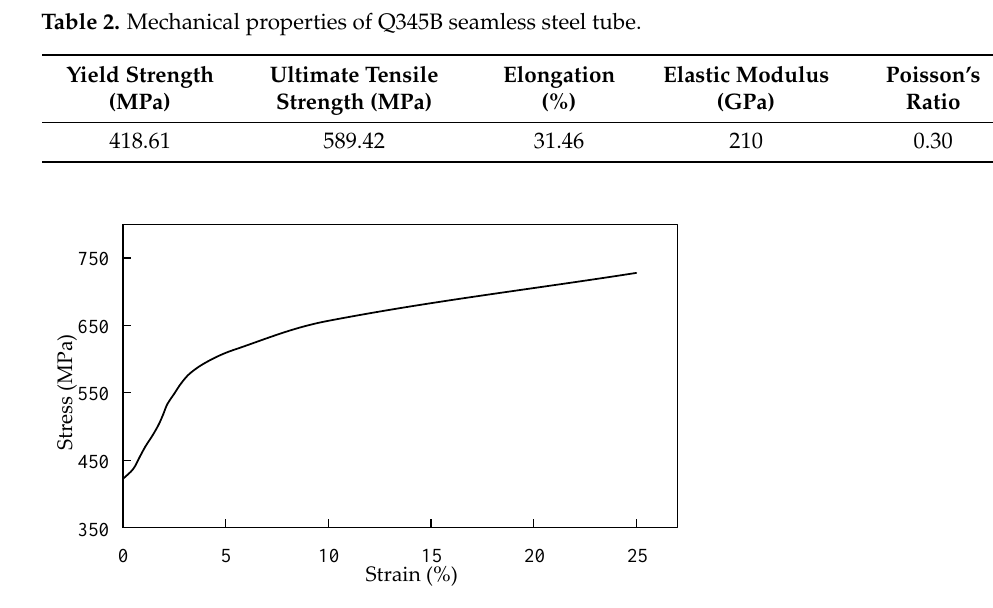
Figure 2. Stress-strain curve of the initial tube. On the tube’s outer surface, the circles are drawn with equal spacing of 145 mm and the axial lines are drawn with an equal circumferential interval angle of 15°. Accordingly, the intersection of the circle and axial lines is the wall thickness measuring point, the sec- tions where the circles are located are designated as cross-section P 1 to P 10 , respectively, as shown in Figure 3.